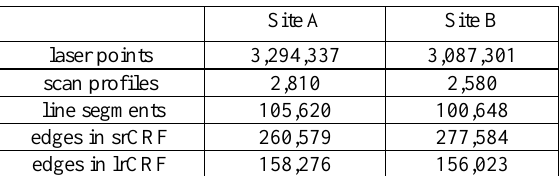
Tabel 1. Total number of the entities: laser point, scan profiles, line segments and edges used in srCRF and lrCRF.